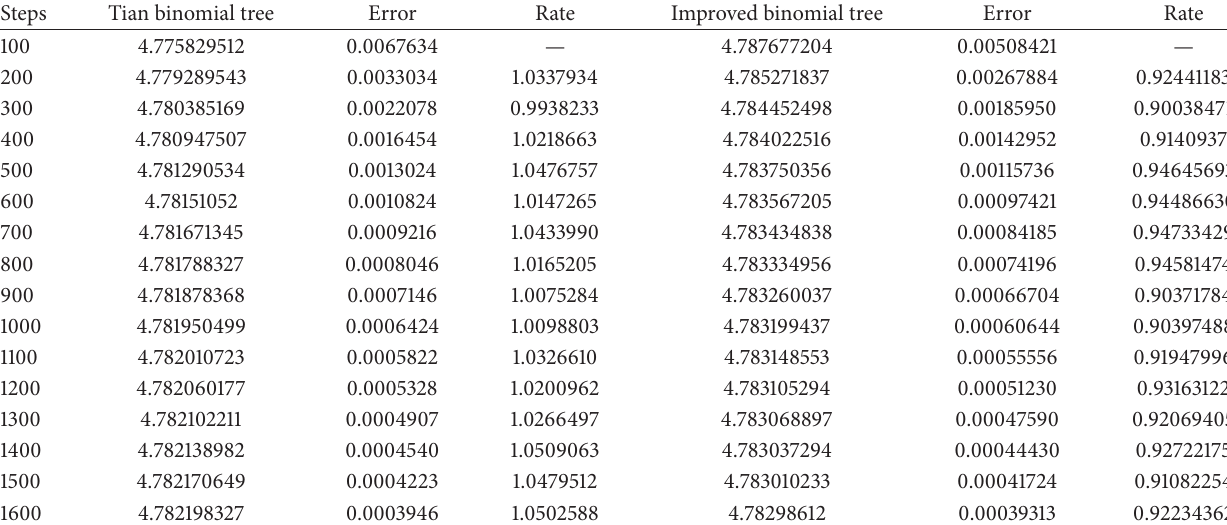
Table 4: Numerical results for Example 4.